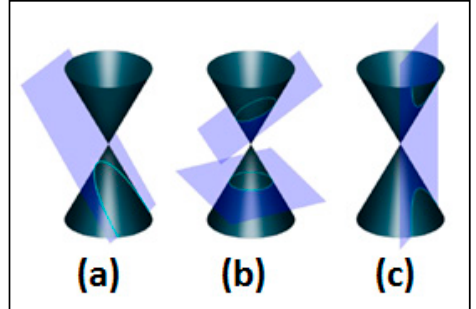
Figure 1. Conic sections: ( a ) parabola; ( b ) circle/ellipse and ( c ) hyperbola.